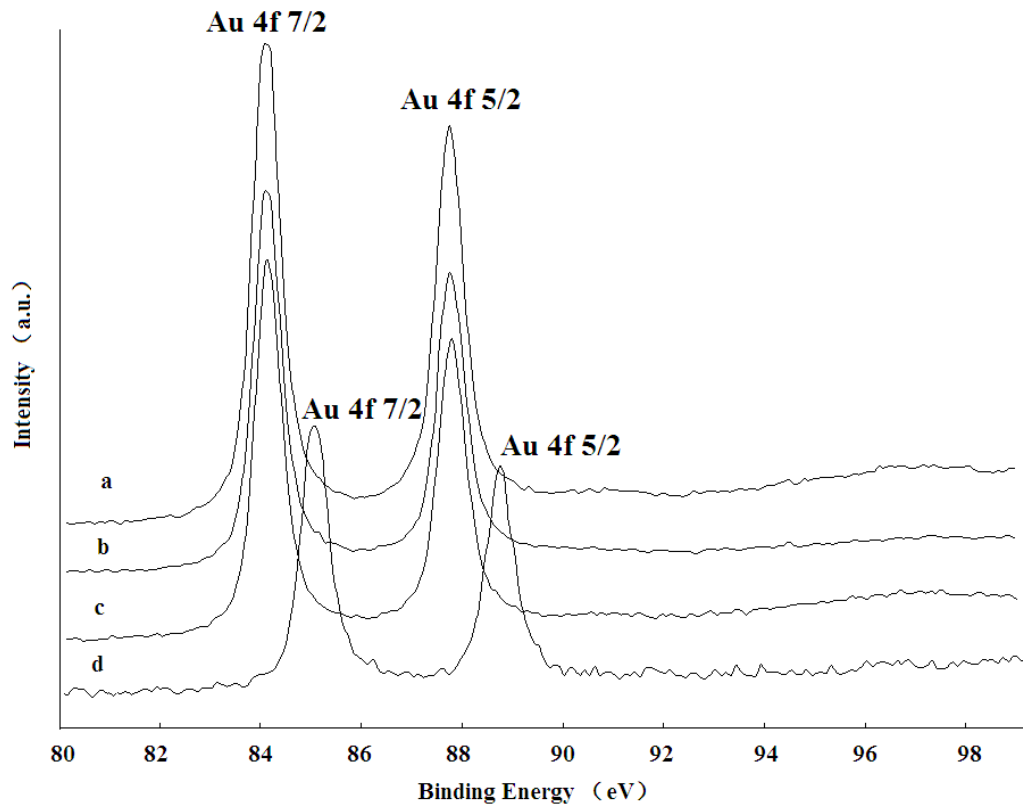
Figure 5. XPS spectra of Au 4f regions recorded for the (a) calcined catalyst before reaction; (b) bioreduced catalyst without calcinations; (c) calcined catalyst after reaction and (d) pure support-absorbed chloroauric